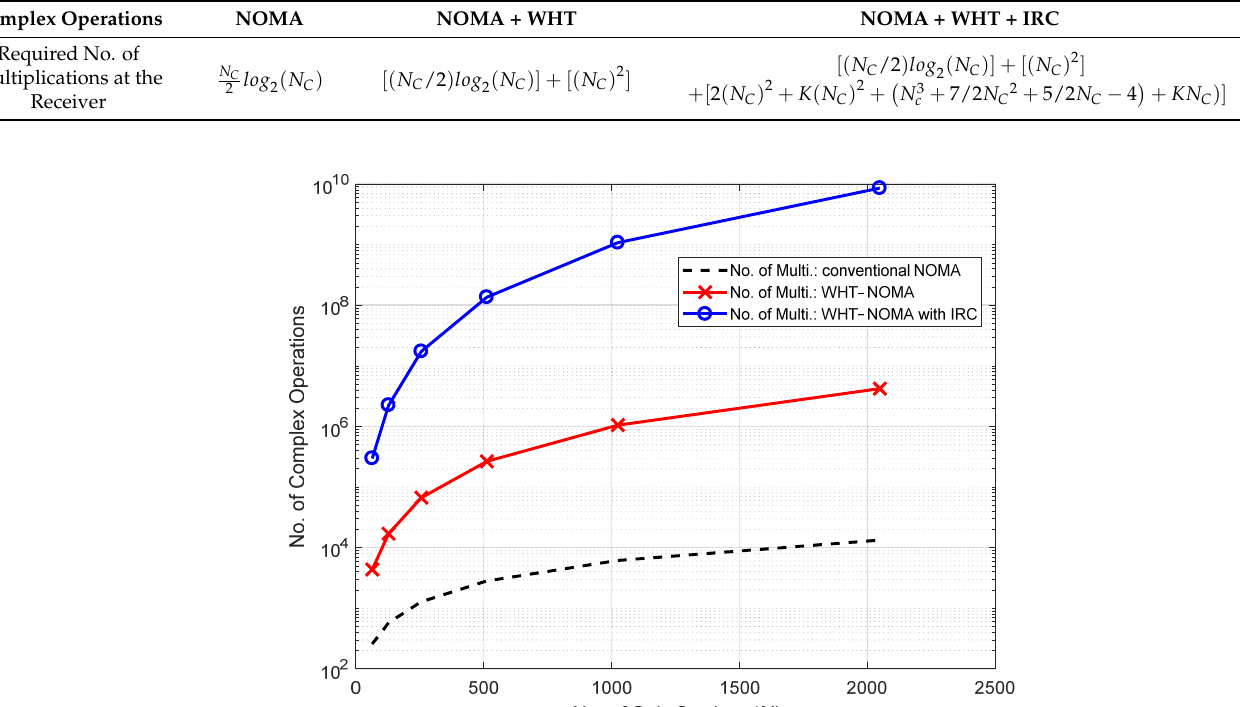
Figure 21. Throughput performance with IRC and 8-QAM modulation; NOMA vs. WHT–NOMA, power allocation: SCU = 0.2 and SEU = 0.8.